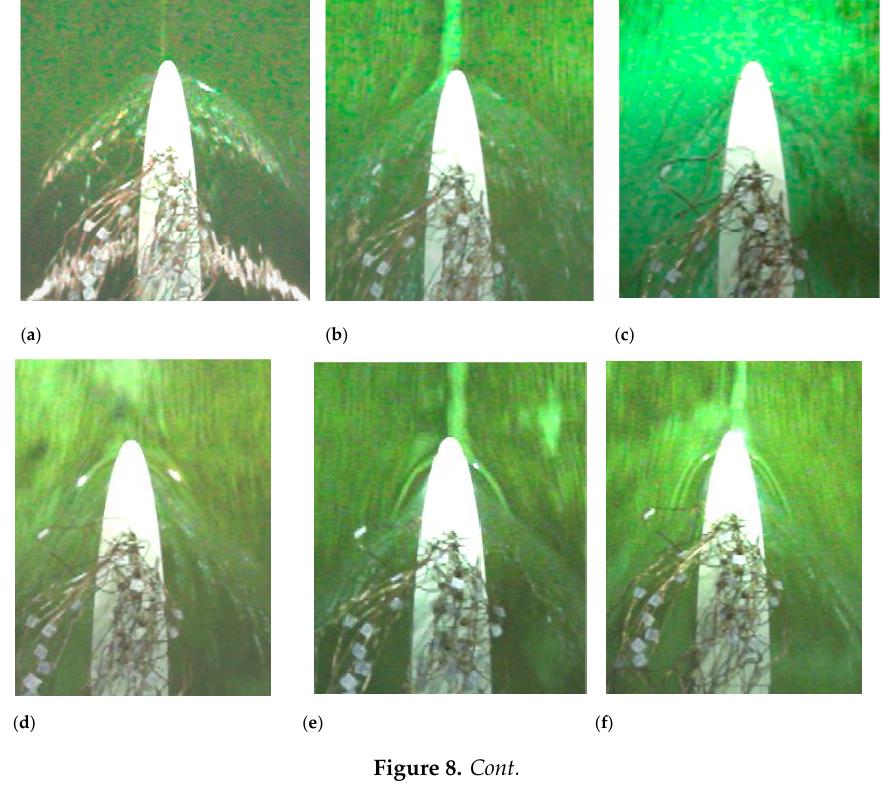
Figure 7. Photos of ships with the visible shift of the bow Kelvin waves system. ( a ) Yacht of the English shipyard Sunseeker; ( b ) American aircraft carrier; ( c ) destroyer; ( d ) cruiser of the project 1164type